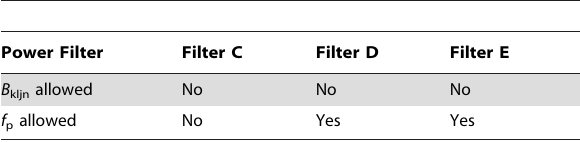
Table 4. Truth table of power filter when a host is in State 2 (active host).